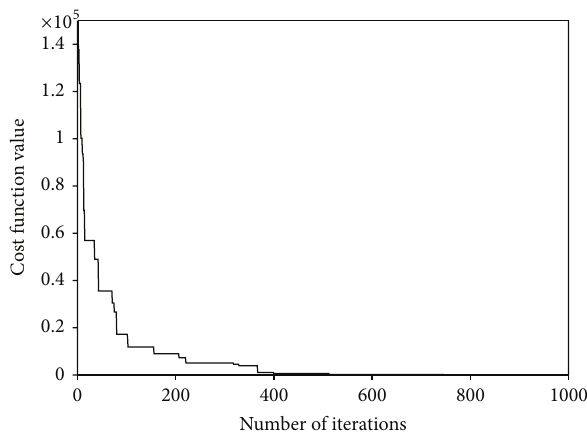
Figure 7: Radiation pattern obtained by controlling the amplitude only with triple null at 14 ∘ , 26 ∘ , and 33 ∘ .